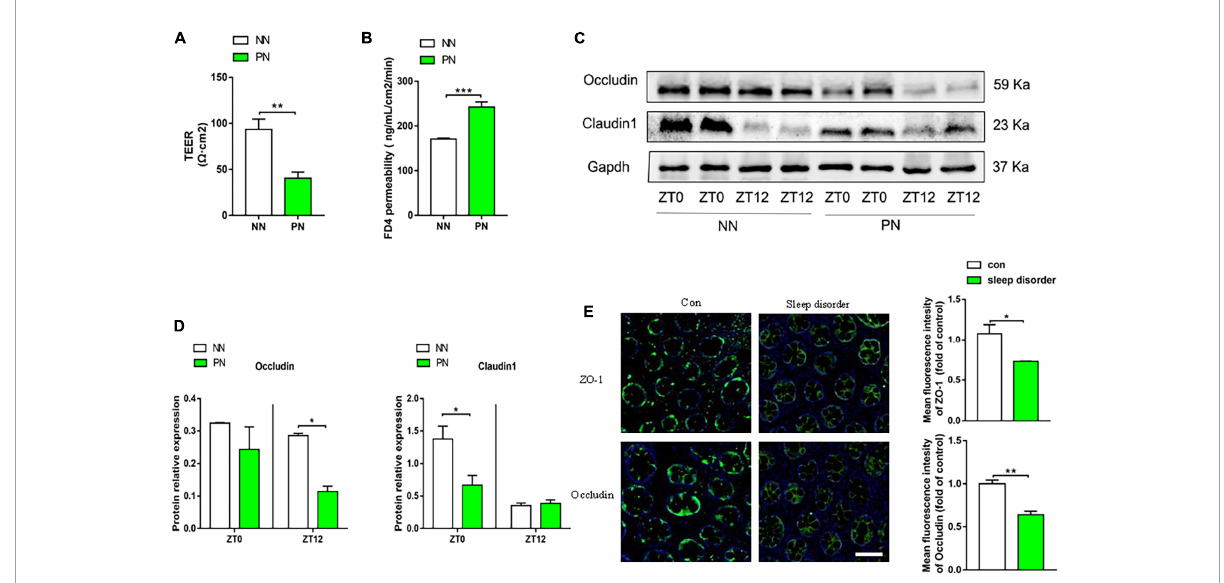
FIGURE3 Light/dark phase shift increases intestinal permeability and is related to the disrupted epithelial barrier. (A) TEER of colonic mucosa of mice. (B) Permeability of mice colonic mucosa to FD4. (C) The protein levels of occludin and claudin1 in colon tissue at ZT0 and ZT12 of the NN and PN groups. (D) The relative quantitative analysis of protein levels of occludin and claudin1 in mice colon tissue. (E) Fluorescence expression of ZO-1 and occludin in the colonic tissue of normal controls and patients with sleep disorders. Scale bar, 100 µ m. Data are expressed as the mean ± SEM. Comparison between two groups performed with a two-tailed Student’s t -test. * P < 0.05, ** P < 0.01, *** P < 0.001. NN, Non-phase shift; PN, Phase shift; TEER, Transepithelial resistance; FD4, FITC-dextran of 4kD; ZT, zeitgeber